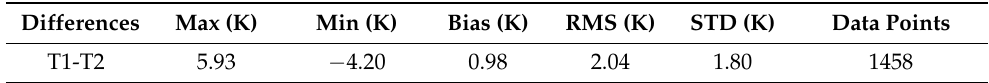
Figure 3. FAA1 station: ( a ) comparison between the surface temperature from the ground weather station (T1, red dots) and from the site-wise VMF1/ECMWF files (T2, blue dots); ( b ) histograms of the temperature differences between the surface temperature from the ground weather station (T1) and from the site-wise VMF1/ECMWF files (T2). Table 3. Statistical summary for the comparisons (Figure 3) between the surface temperature from the ground weather station (T1) and from the site-wise VMF1/ECMWF files (T2) (T1 minus T2) in terms of max, min, bias, STD, and RMS.